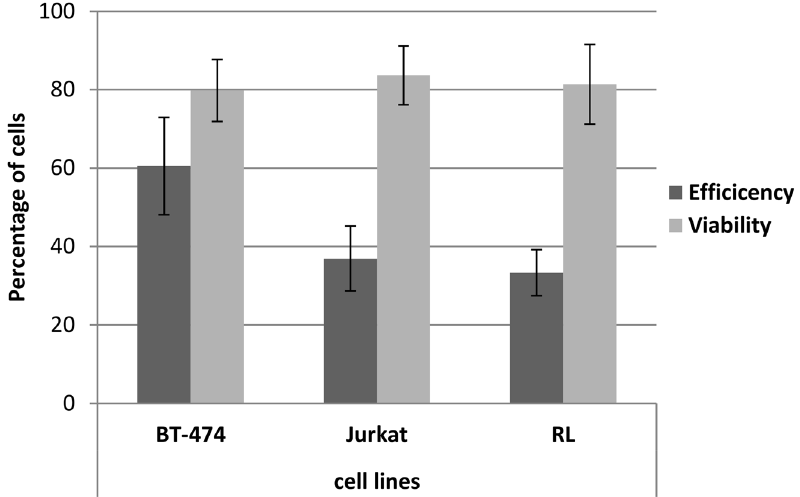
Fig 5. Biological reproducibility of the device. Assays were conducted on two non-adherent cell lines cell lines (RL and Jurkat) and one adherent cell line (BT474). Sonoporation was performed using the optimal parameters (10.10 6 cells/ml, IC of 12 for 30 seconds and 10 μ g of pEGFP-C1). Twenty-four hours post- transfection cells were collected and analyzed for transfection efficiency (% GFP+ cells) and for viability (% of cells excluding PI). All experiments were performed at least in triplicate and repeated independently three times for each cell line. Statistical analysis using a non-parametric Wilcoxon test demonstrated no significant difference in transfection efficiency and in cell